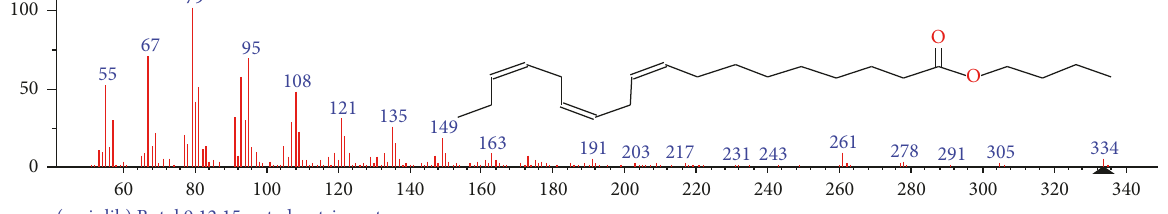
Figure 50: Mass spectrum of compound butyl 9,12,15-octadecatrienoate of whole plant hexane fraction of Achillea wilhelmsii (WHFAW).